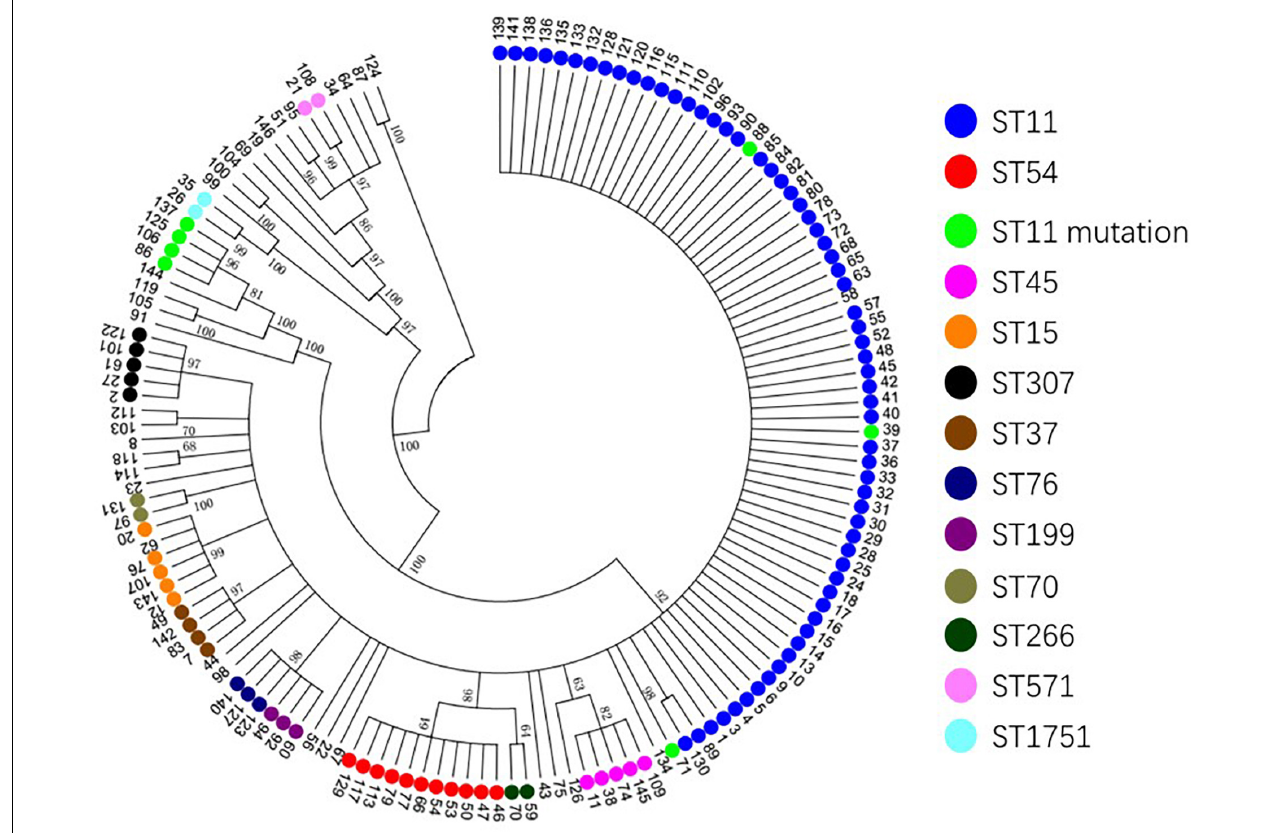
FIGURE 4 | The evolutionary tree of CR-KP. Taking 50% as the cut-off value, different branches represent an evolutionary population. The number represents different samples, and colors represent different